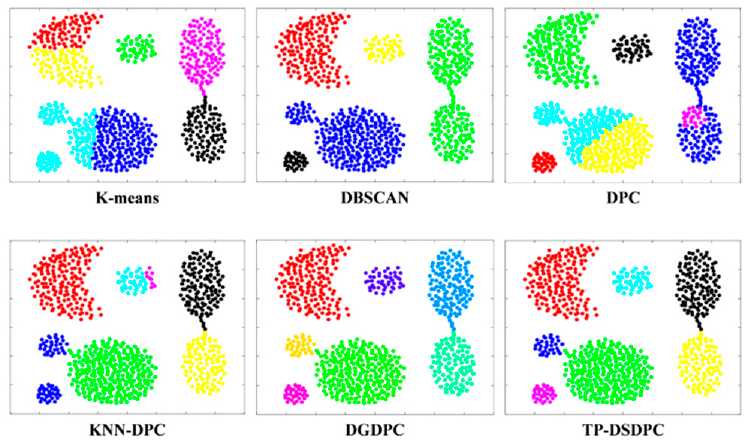
Figure 12. Clustering results on